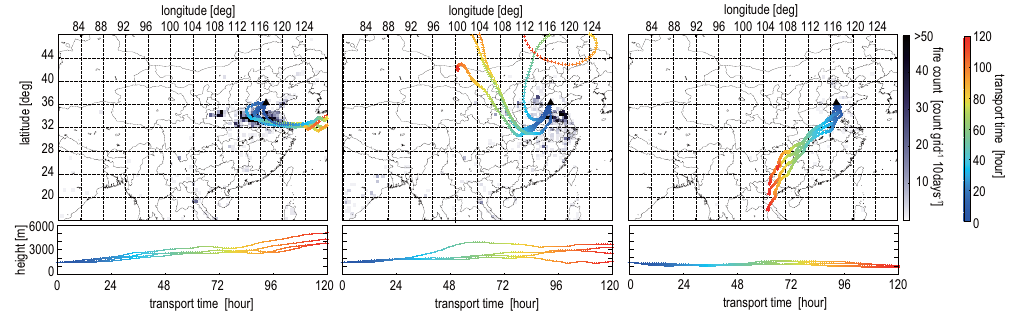
Fig. 5. Hotspot counts (count 10 days − 1 grid − 1 ) observed by Aqua/Terra MODIS for (a) 1–10 June, (b) 11–20 June, and (c) 21–30 June and backward trajectories calculated by the meteorological data explorer (CGER-METEX) on (a) 7 June, (b) 12 June, (c) 28